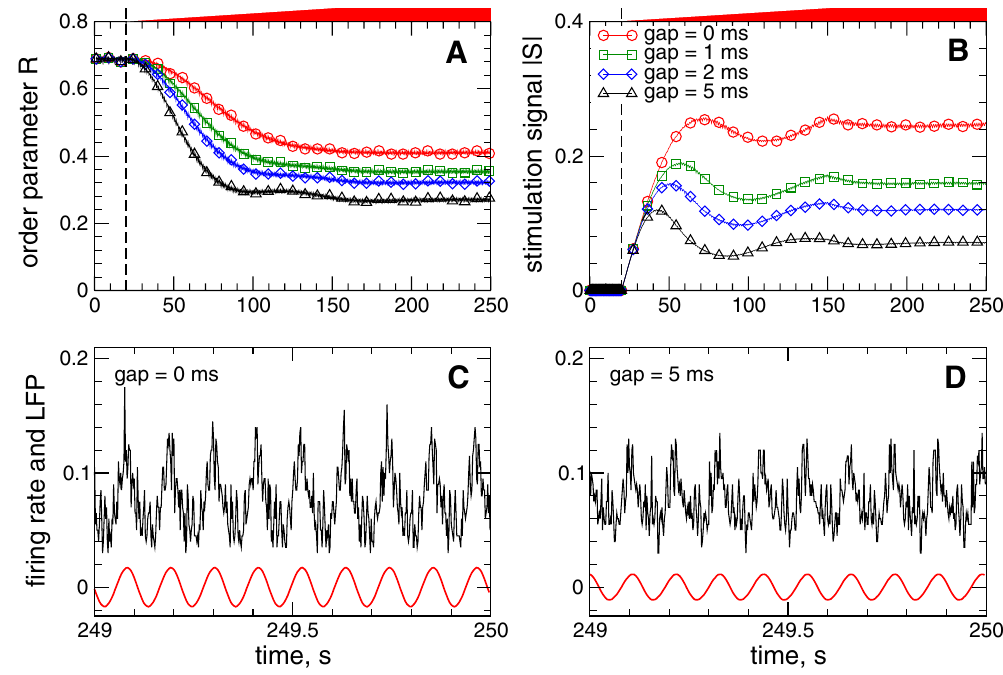
Figure 5. Suppression of synchronization in the neuronal ensemble (1) - (3) by pulsatile NDF stimulation (7). Time courses of ( A ) the order parameter R of STN neurons and ( B ) absolute value | S | of the feedback signal (7) are depicted for different widths of the interphase gap [Fig. 3B in Methods] as indicated in the legend in plot ( B ). Only the local maxima of the oscillating signal | S | are shown in plot ( B ). The stimulation starts at t = 20 s indicated by vertical dashed lines, where the parameter of the stimulation intensity K linearly increases and reaches its maximal value K = 50000 at t = 150 s as indicated by red bars on top of the plots. In plots ( C , D ) the corresponding time courses of the firing rate (black curves) and filtered LFP (red curves) are depicted for gap widths 0 ms and 5 ms as indicated in the plots. Parameter of the stimulation delay τ = 150 ms.